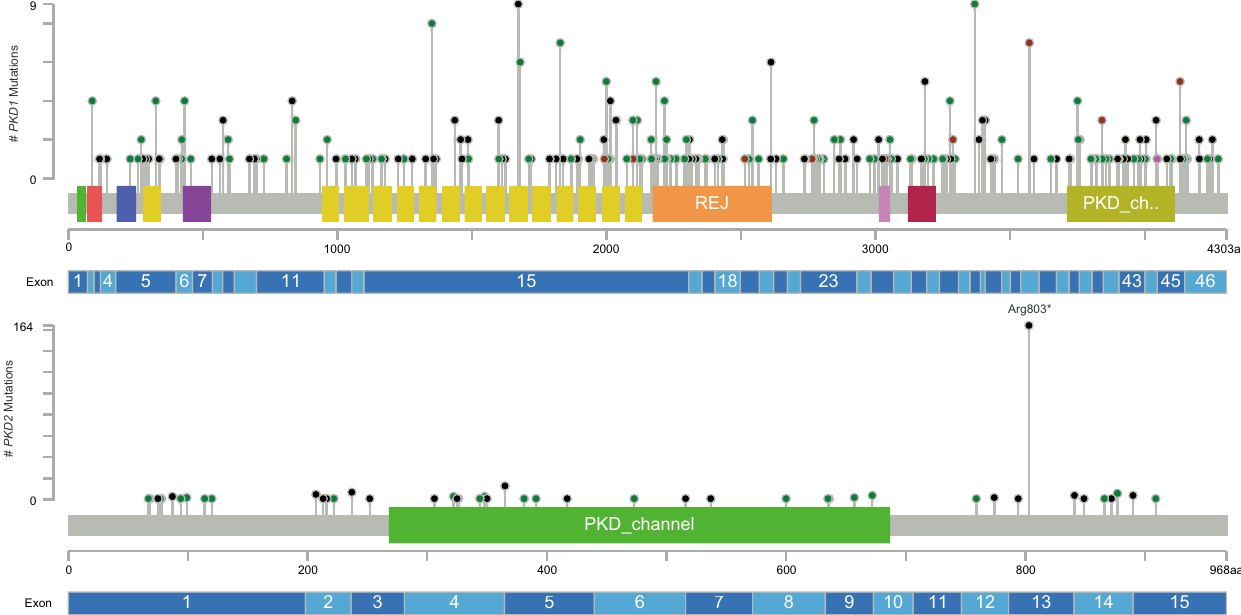
Fig. 2 Variants distribution of PKD1 and PKD2 genes. Variants in the PKD1 and PKD2 distributed evenly across genes with no single variant exceeded 1.2% of the cohort if the PKD2 p.Arg803* variant was excluded. Figures were created and modi fi ed by using the MutationMapper 49